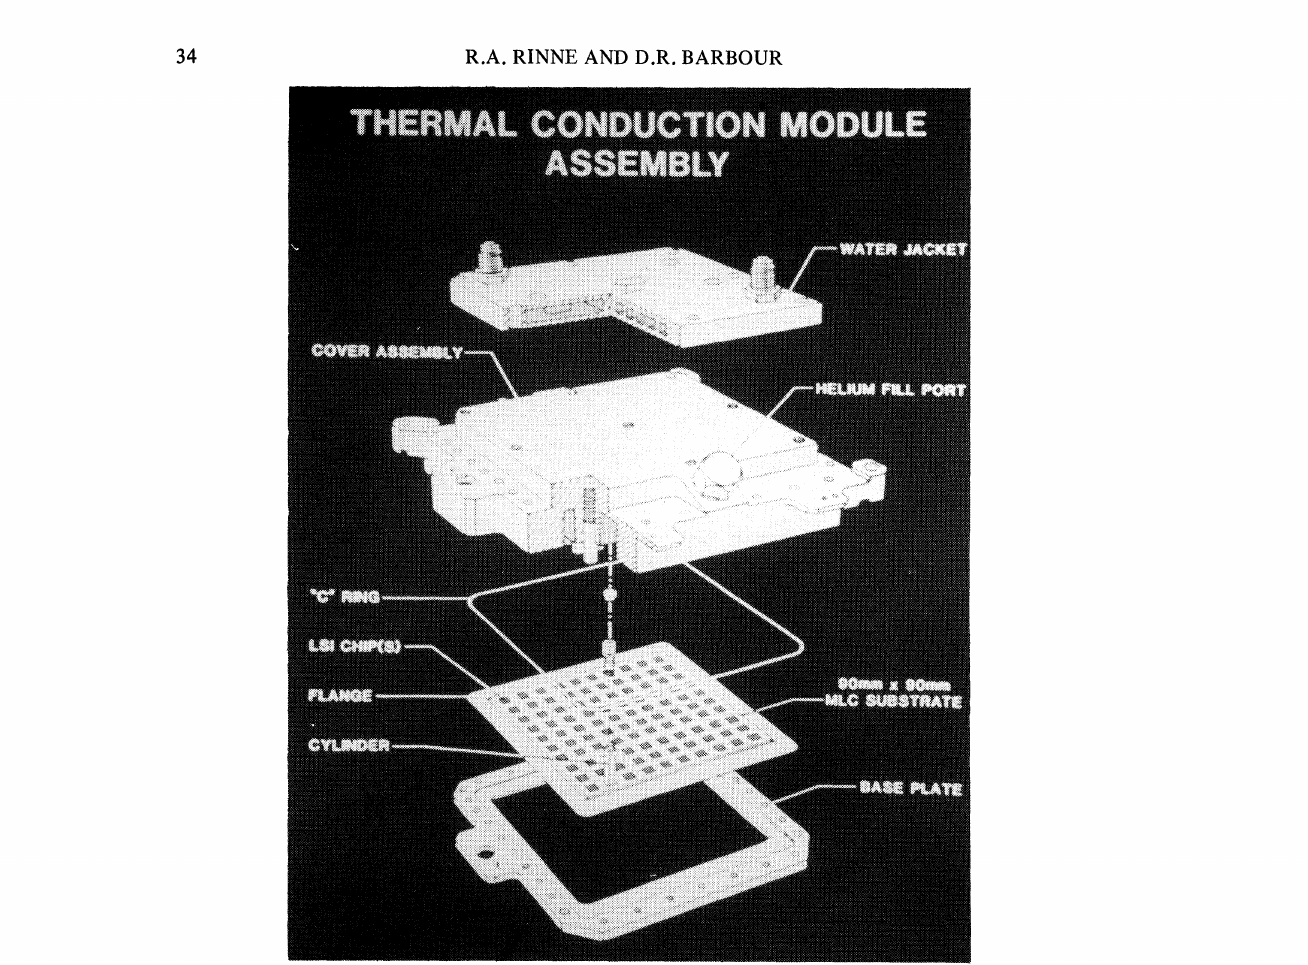
FIGURE 4 Thermal conduction module